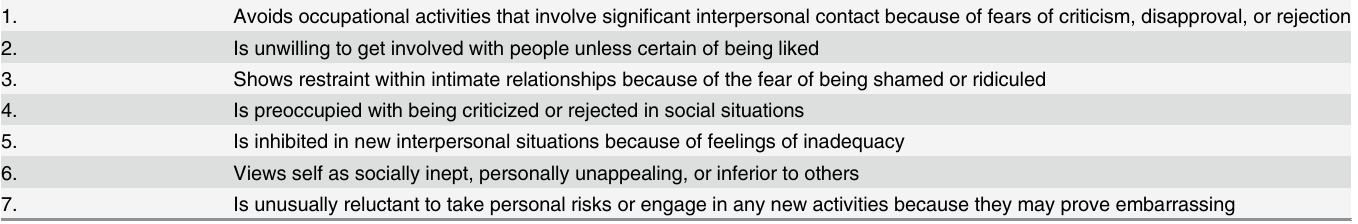
Table 1. DSM-IV diagnostic criteria for